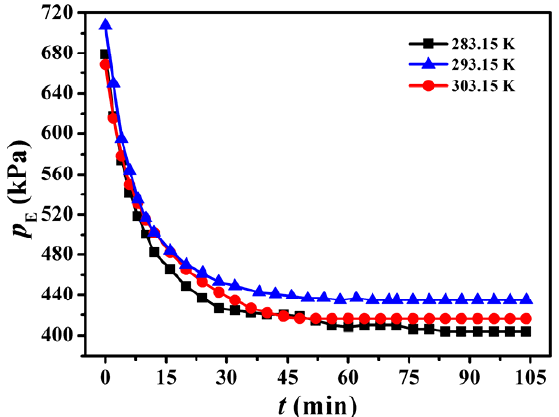
Figure 8. Comparison of the dynamic curves under different inlet pressures at 293.15 K. The mass ratio between water and glycol in the ZIF-8/water-glycol (20%) slurry was specified to 4:1 with 20 wt % ZIF-8.